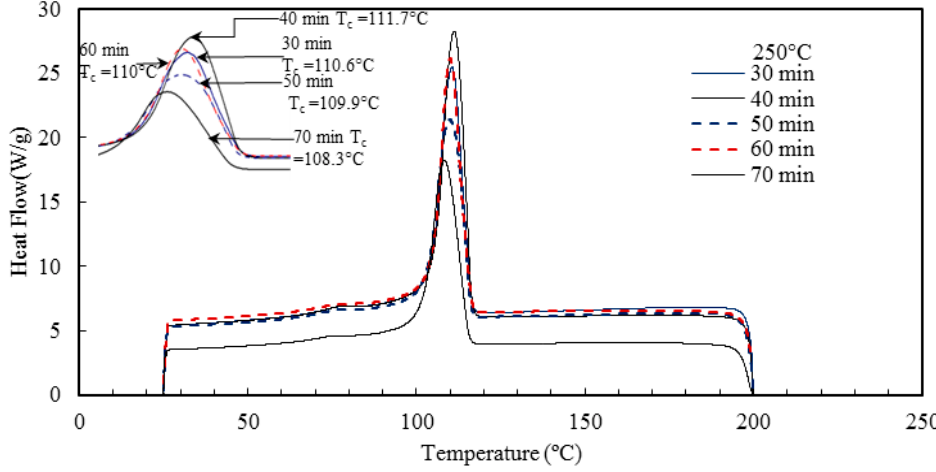
Figure 19. Effect of barrel temperature on the crystallization temperature of the injection molded HDPE/TiO 2 nanocomposites. Table 6. DSC results showing the influence of residence time.